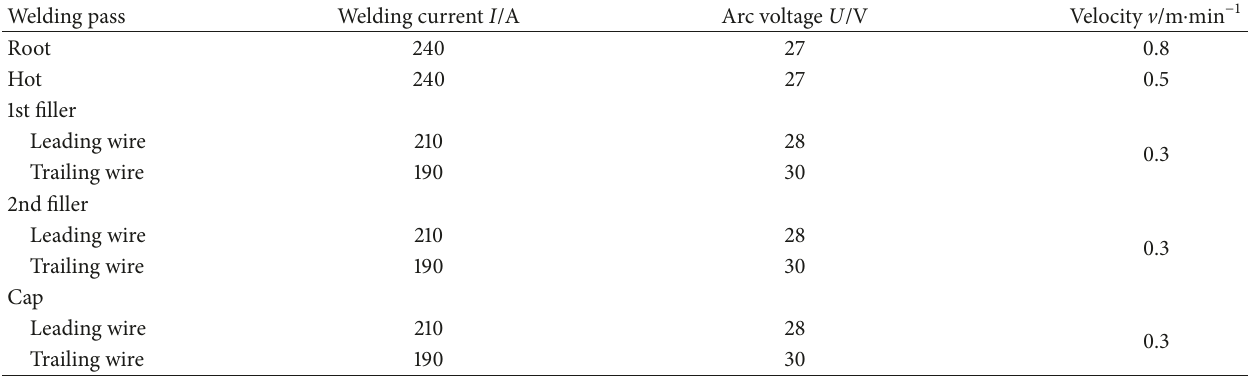
Table 3: Welding parameters.